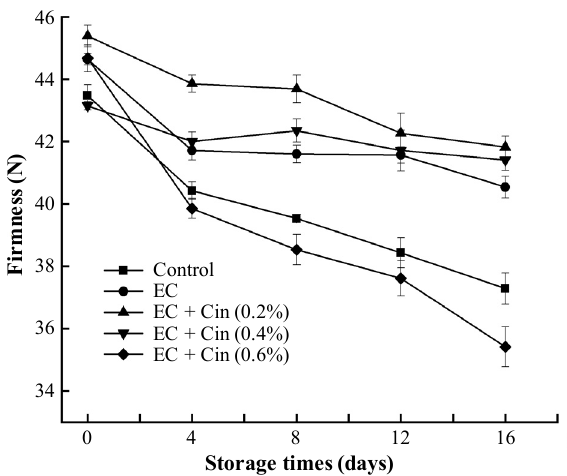
Figure 4. Changes in firmness of fresh-cut potatoes coated with chitosan-based EC containing cinnamon oil. Control: uncoated; EC: edible coating; Cin: cinnamon oil. Bars represent means ± SD ( n = 3, p < 0.05).